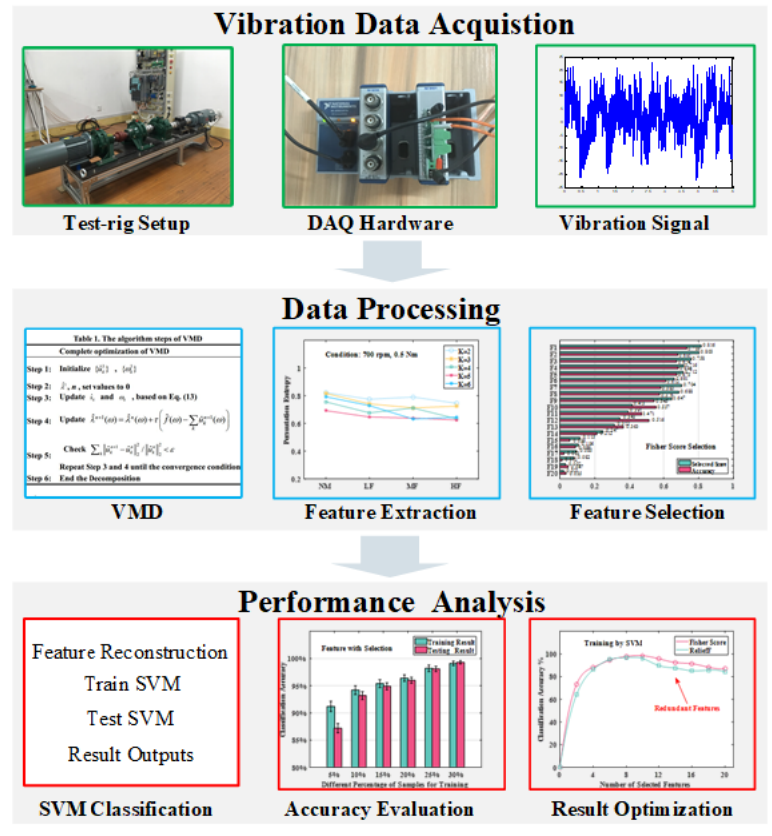
Figure 2. Main framework of the proposed method.